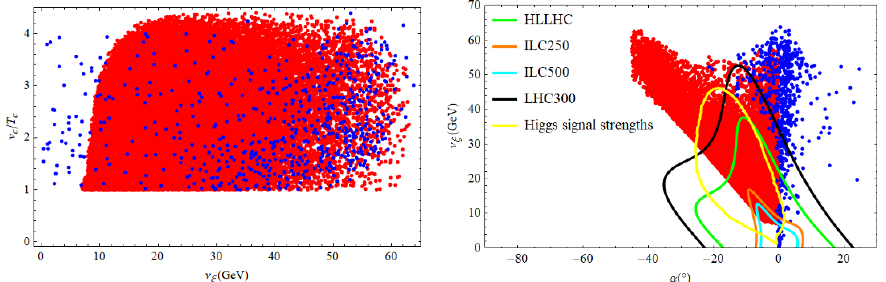
Figure 5 . Left:The v C =T C as a function of v (cid:24) for one step(red) and two-step phase transition(blue); right: the v C =T C > 1 viable points in the plane of (cid:11) - v (cid:24) for one step and two-step SFOEWPT.